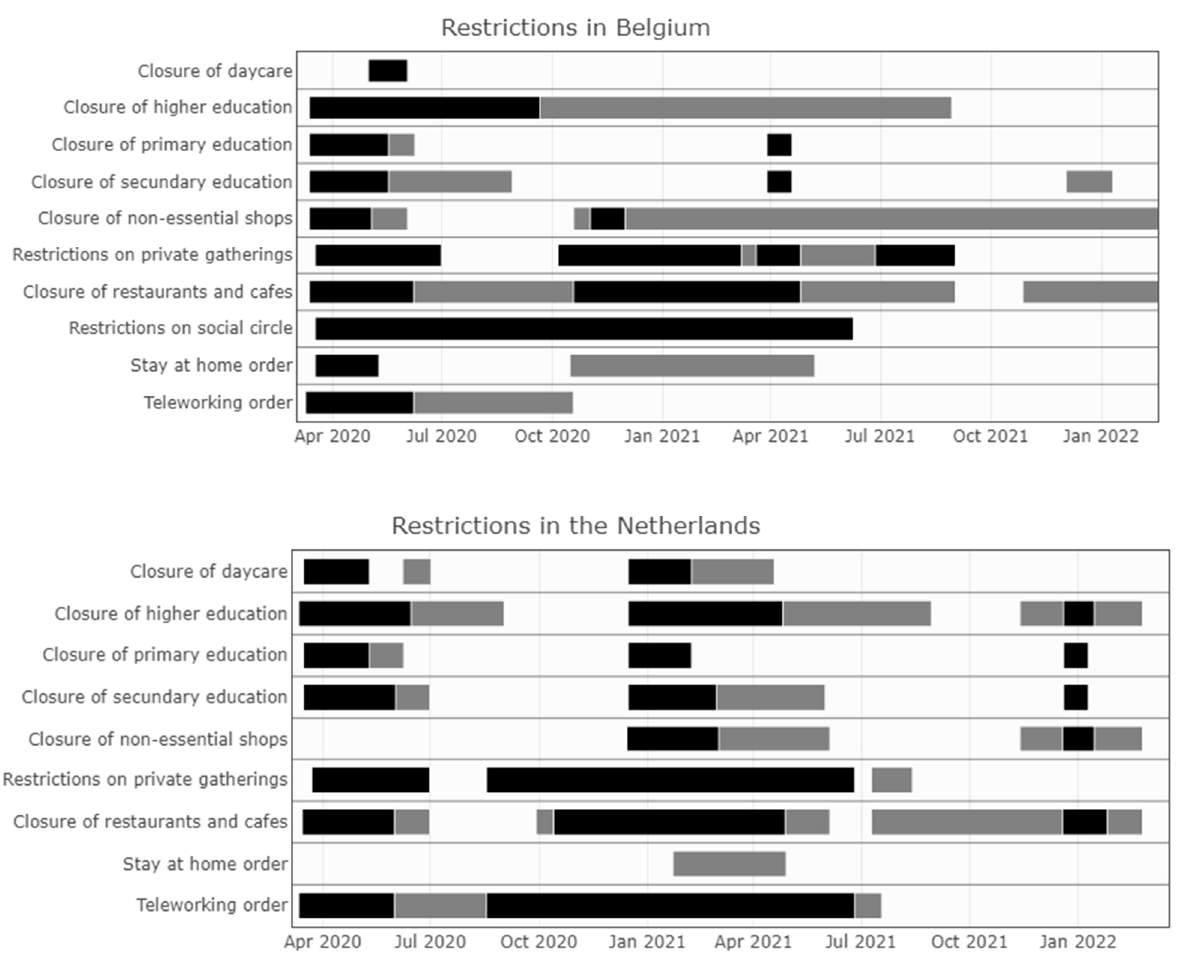
Figure 4. Stringency of non-pharmaceutical interventions (NPIs) for Belgium and its neighboring countries from the start of the COVID-19 pandemic in March 2020 until January 2022. Higher values indicate stricter NPIs in that period.